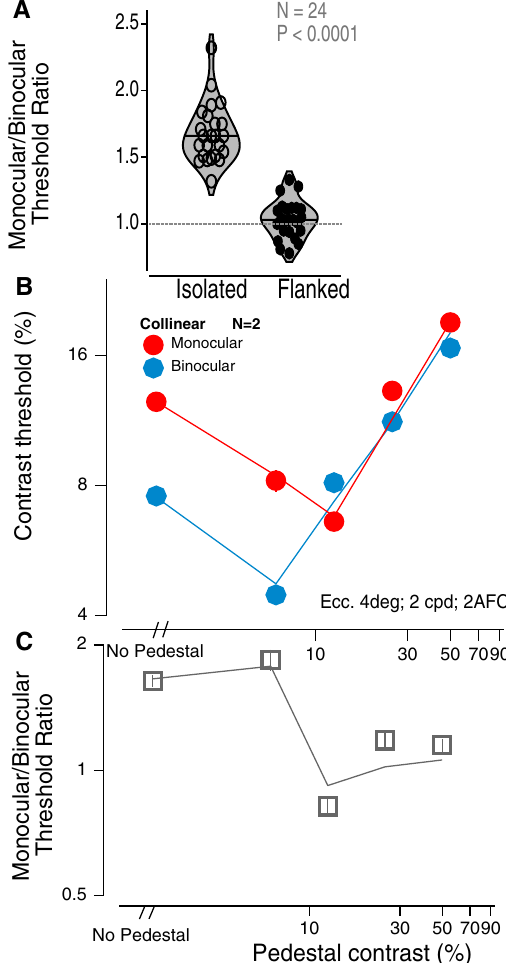
Figure 3. ( A ) The violin plot shows the ratio of monocular to binocular thresholds for 24 independent paired measures (from 16 different observers from experiments 1–5) for isolated vs. closely spaced flanks). The binocular advantage is significantly greater for isolated than for closely flanked stimuli (P < 0.0001). ( B ) Contrast discrimination threshold vs. Pedestal (superimposed flank) contrast. Data from 2 observers. The solid lines are the Ding–Sperling gain control model with uncertainty and multiplicative noise (GUM model: Fig. 5B). ( C ) The monocular:binocular threshold ratio as a function of pedestal